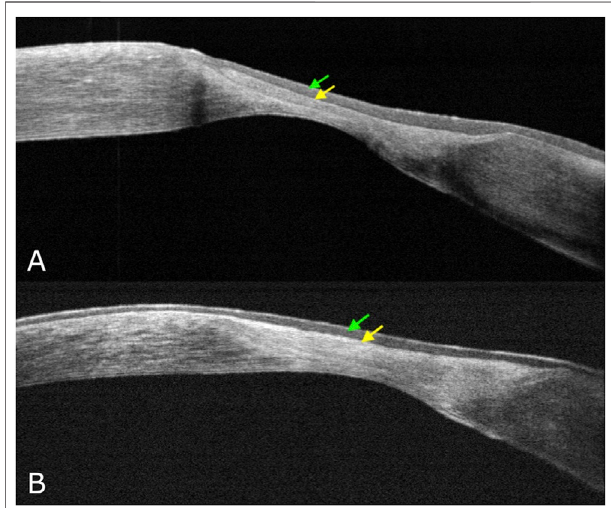
FIGURE 3 | Corneal wound healing AS-OCT detail. First corneal epithelial hypertrophy fi lled the thinning area, then scar tissue formed (A) , and the corneal stroma thickness gradually improved (B) (green arrow points to corneal epithelium; yellow arrow points to corneal stroma).